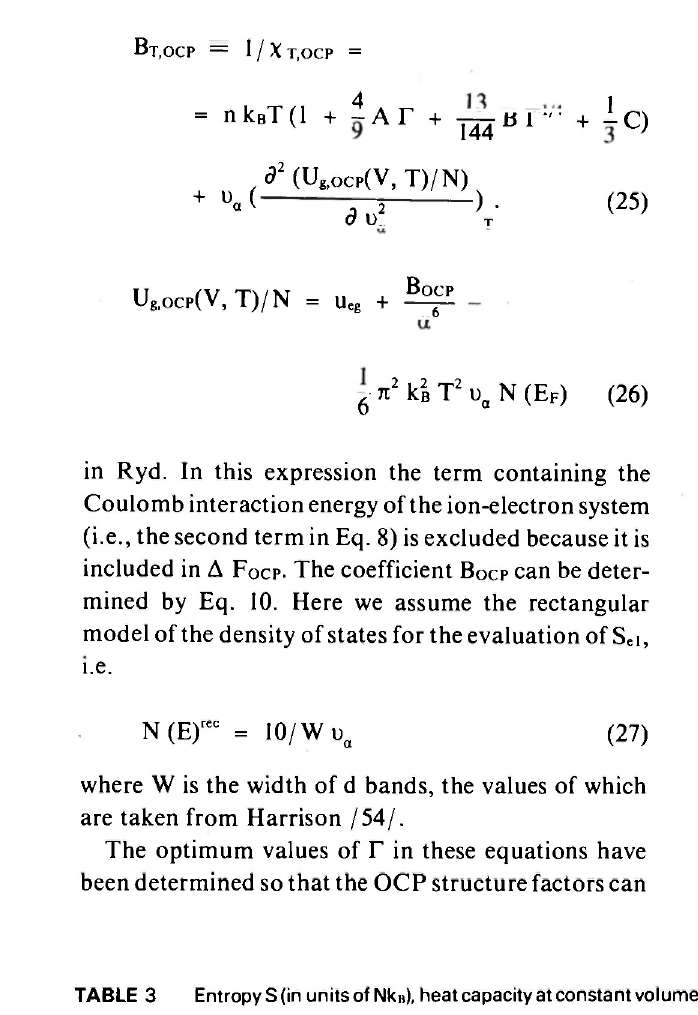
Entropy S (in units of Nk B ), heat capacity at constant volume Cv (in units of Nk B ) and isothermal compressibility χτ<10 1 'm 2 N ')